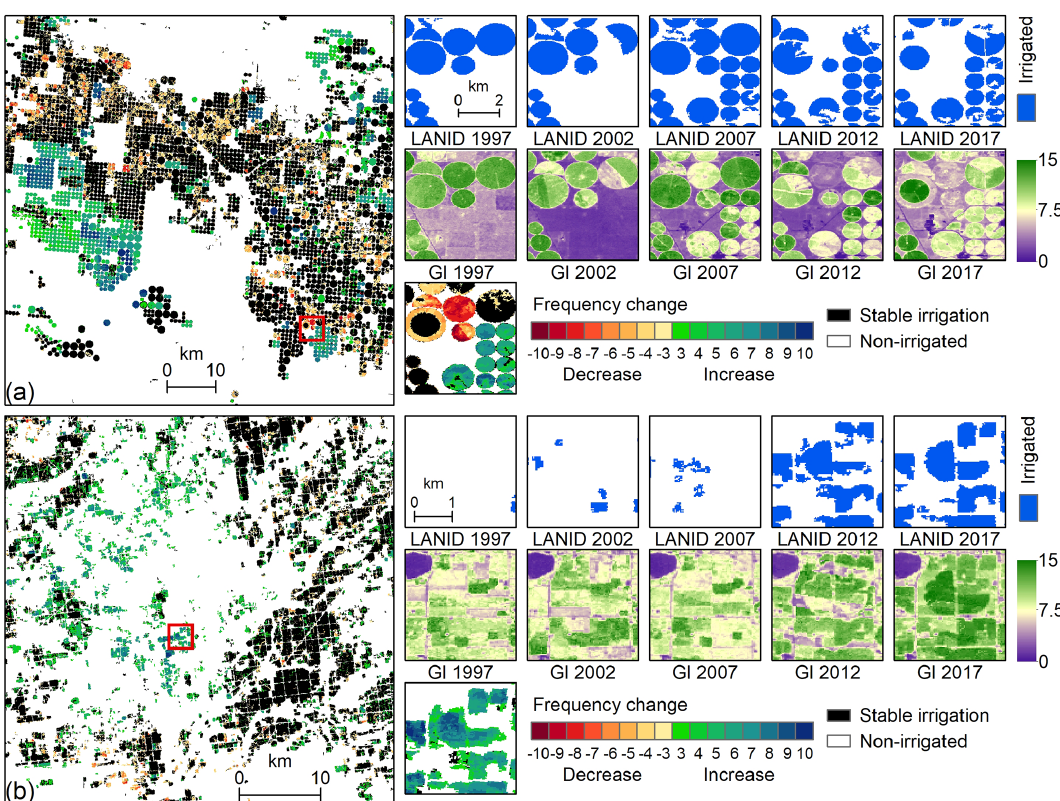
Figure 7. Demonstration of LANID-derived field-level irrigation frequency change for the northern Texas (a) and southwestern Michigan (b) (highlighted in Fig. 6). Frequency change refers to the difference of number of years irrigated between 1998–2007 and that between